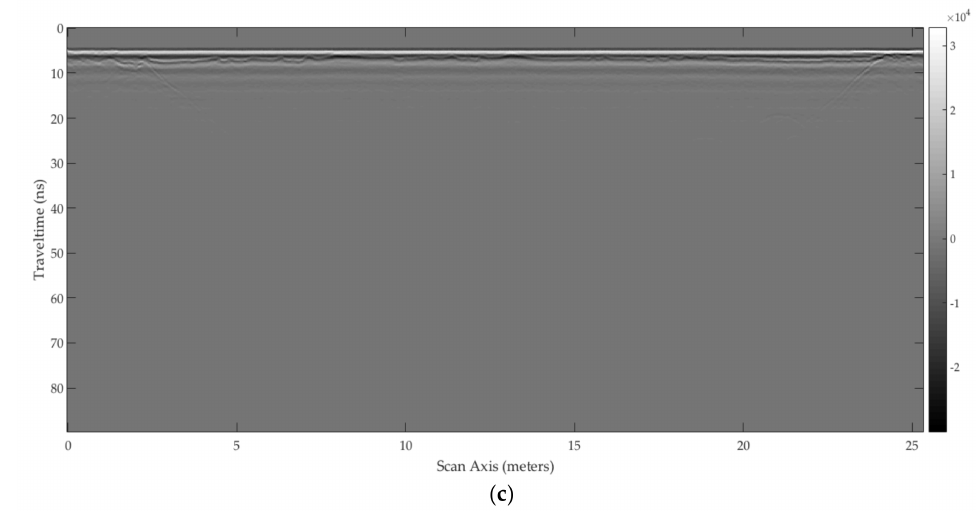
Figure 34. Profiles recorded in the Gneiss 14/20 gravel region by using GPR 2, on acquisition line 2, with antennas operating at: ( a ) 250 MHz; ( b ) 500 MHz; ( c ) 800